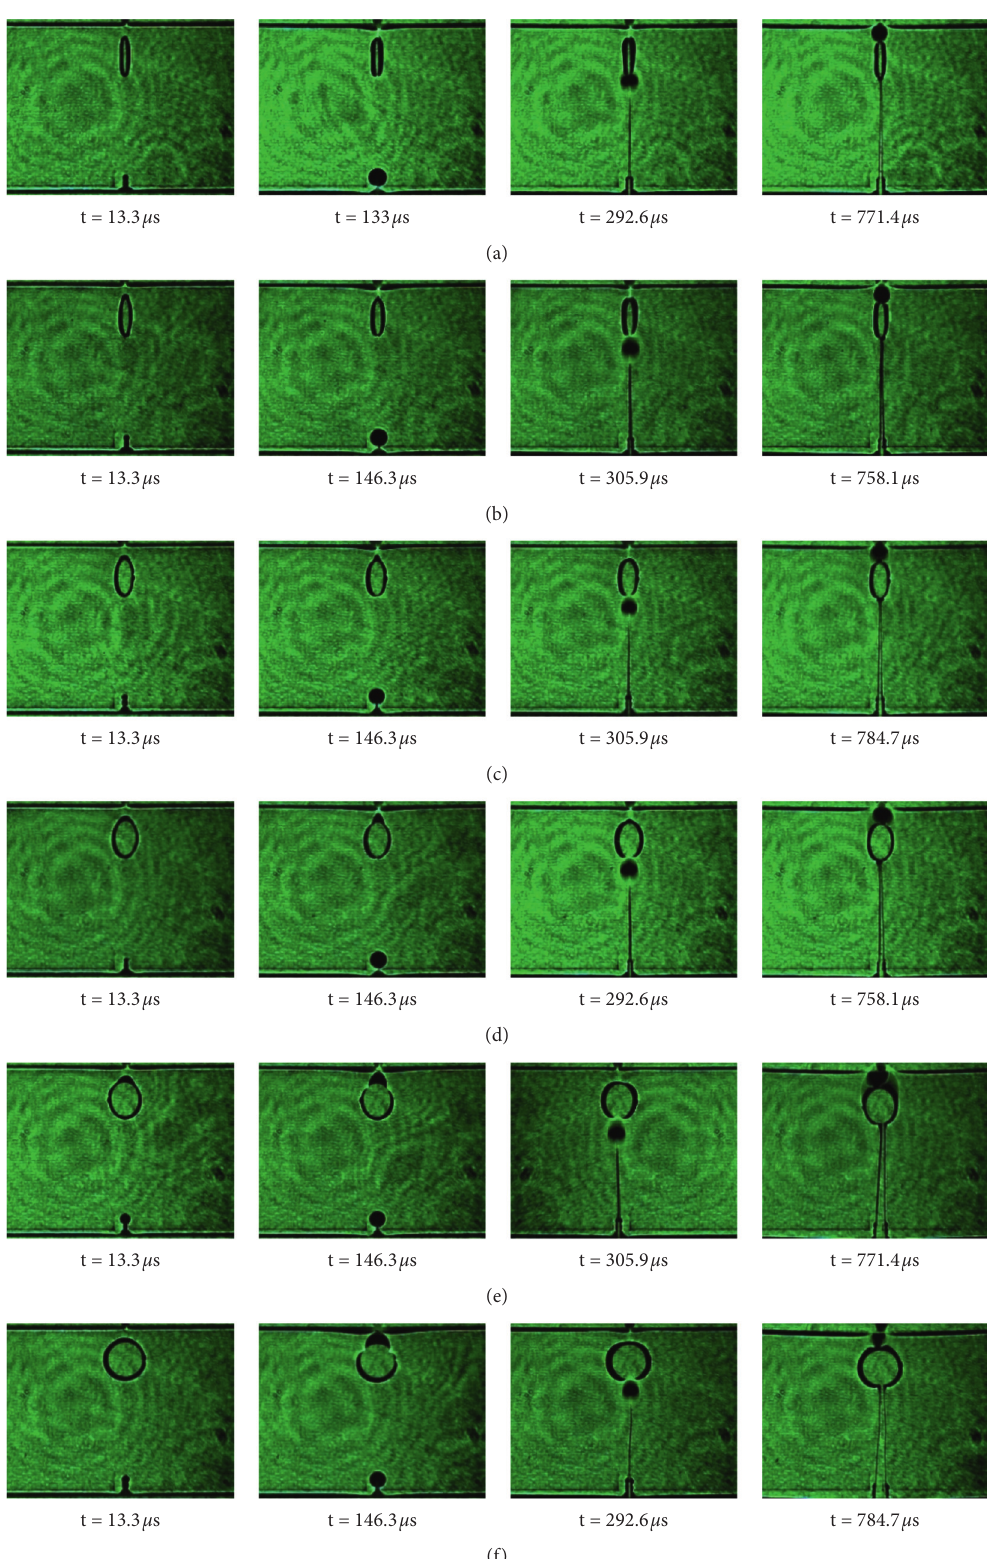
Figure 4: Three-point curved focus speckle schematic. (a) L1. (b) L2. (c) L3. (d) L4. (e) L5. (f)